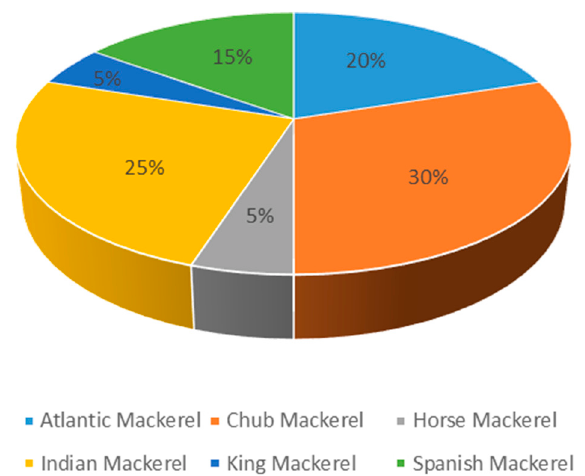
Figure 1. The number of publications related to the effects of frying processes on the nutritional and sensory characteristics of mackerel ( a ), mackerel with marinade and spice ( b ), mackerel with batter ( c ), and minced mackerel products ( d ).